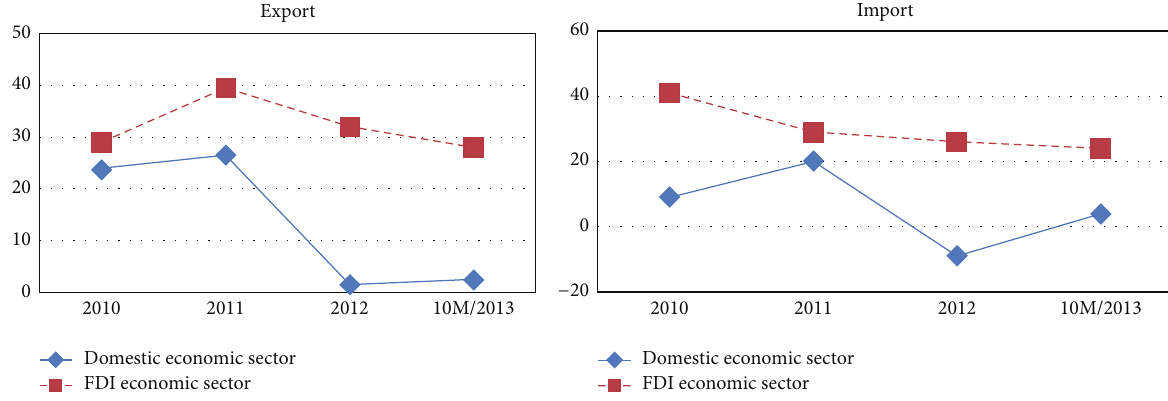
Figure 1: Growth rate of export and import activities (%) (source: General Statistics Office of Vietnam (GSO-VN)).